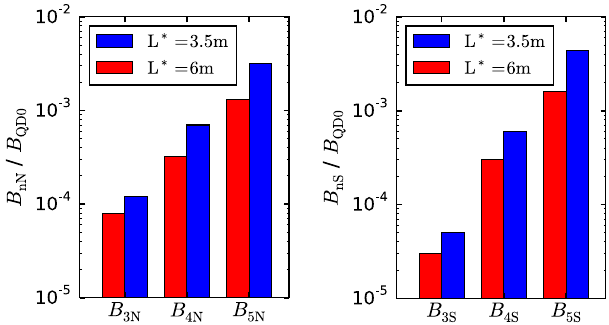
FIG. 12. Normal (left plot) and skew (right plot) sextupole, octupole, and decapole field error tolerances for QD0.